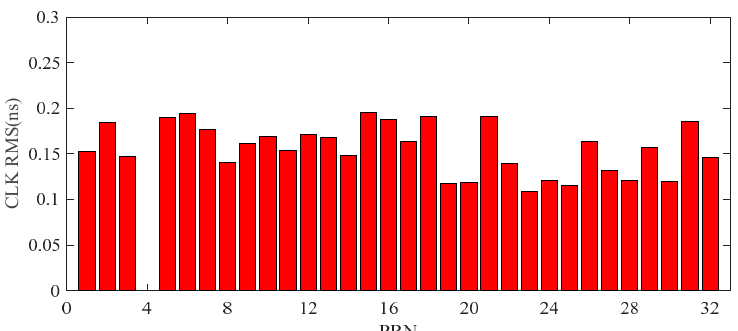
Figure 4. RMS values of corrected satellite clock bias (CLK) using RTS products. CLK is the satellite clock bias, and PRN (Pseudo-Random Noise) stands for the satellite number.